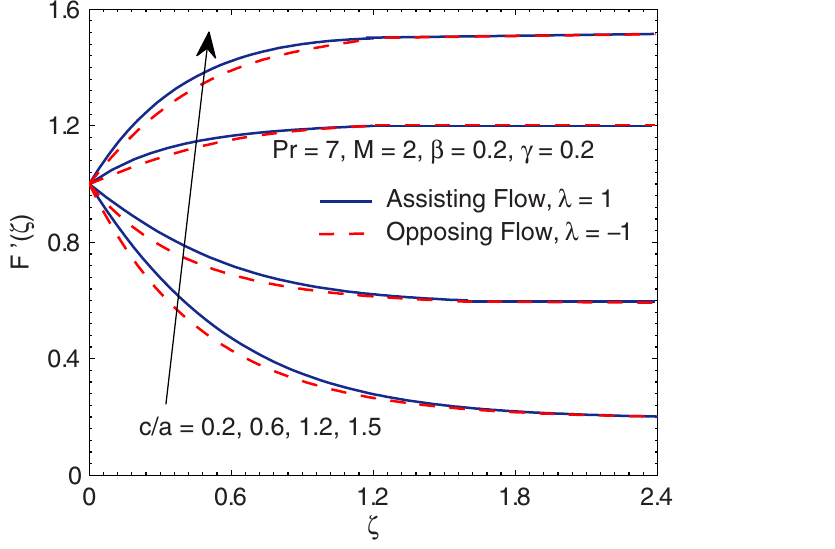
Fig 3. Curves of F 0 for various values of velocity ratio parameter ( c / a